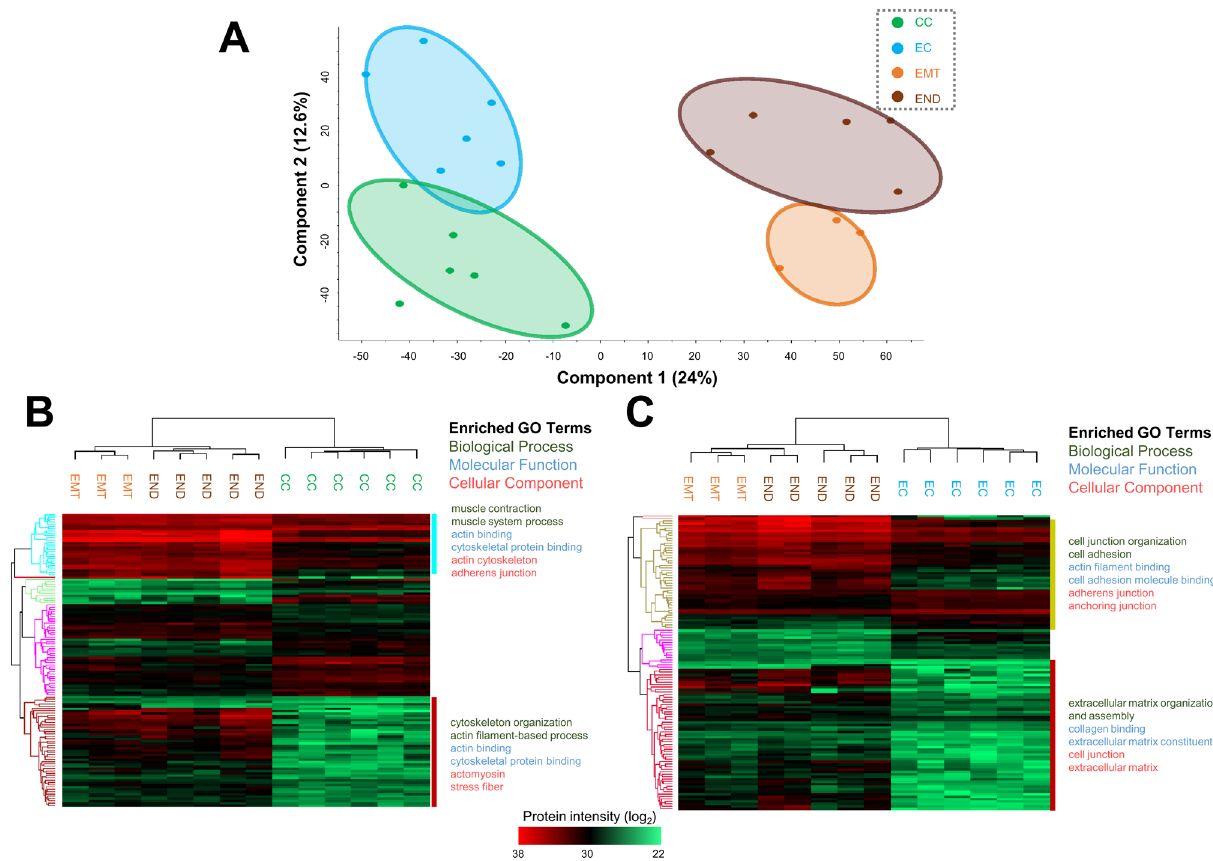
Figure 3. Principal component and clustering analyses. ( A ) Principal component analysis of entire proteomic dataset without enrichment. Hierarchical clustering of differentially-expressed proteins between CC, EMT and END ( B ) and EC, EMT and END ( C ) with overrepresented GO annotations identified through enrichment